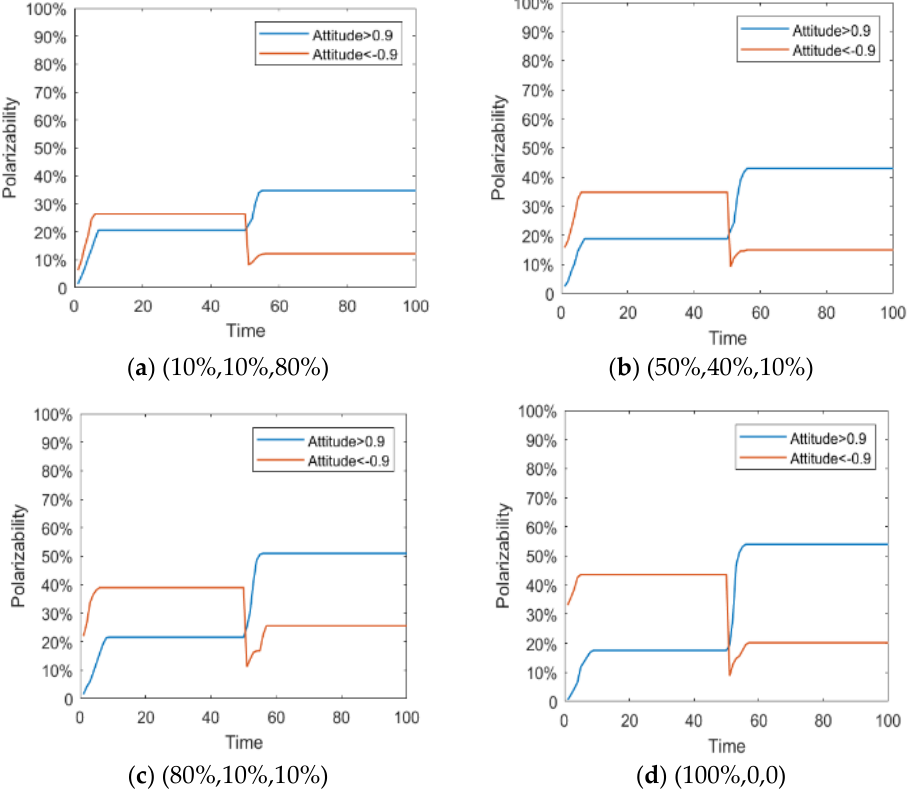
Figure 14. Curve of the group attitude polarization under different proportion. ( a ) (10%,10%,80%); ( b ) (50%,40%,10%); ( c ) (80%,10%,10%); ( d ) (100%,0,0).